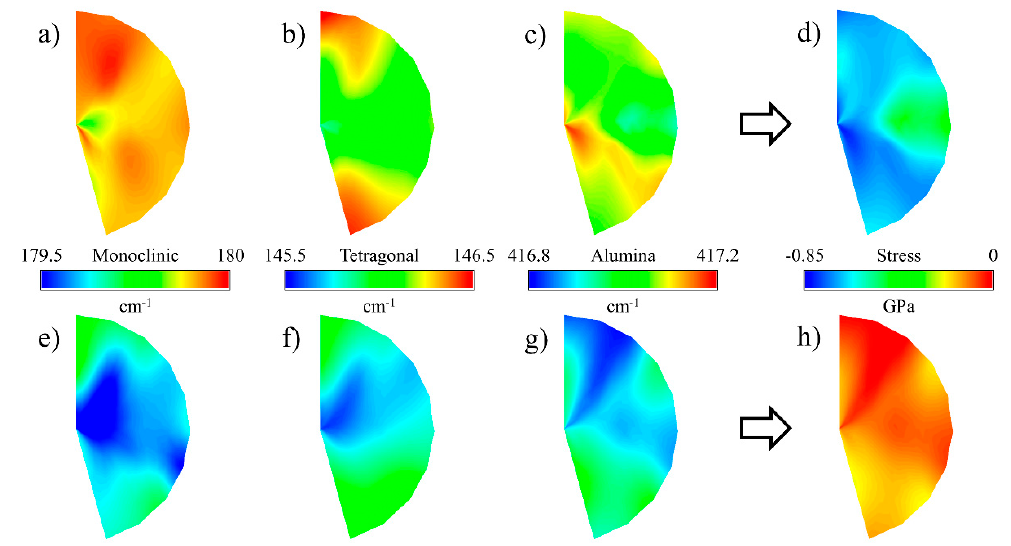
Figure 9. Raman band shifts for monoclinic zirconia, tetragonal zirconia and alumina and equivalent stress on Group 2 ( top row ) and pristine ( bottom row ) femoral head.